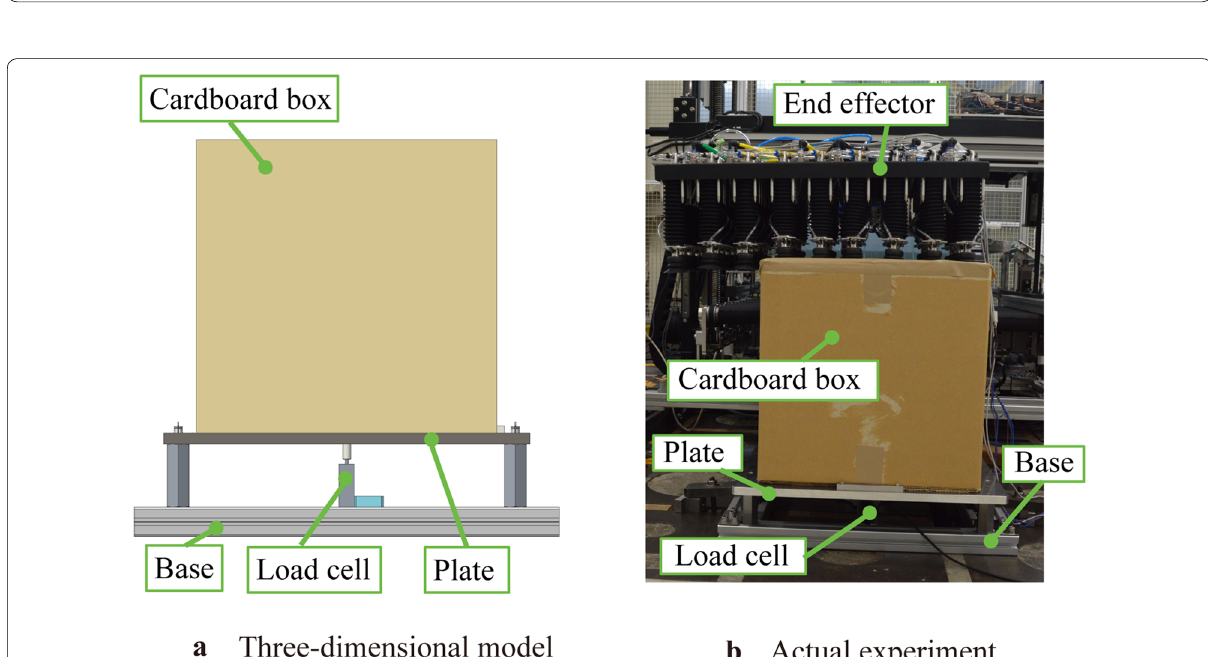
Fig. 29 Contraction force evaluation test apparatus for the end effector alone. a Three-dimensional model, b actual